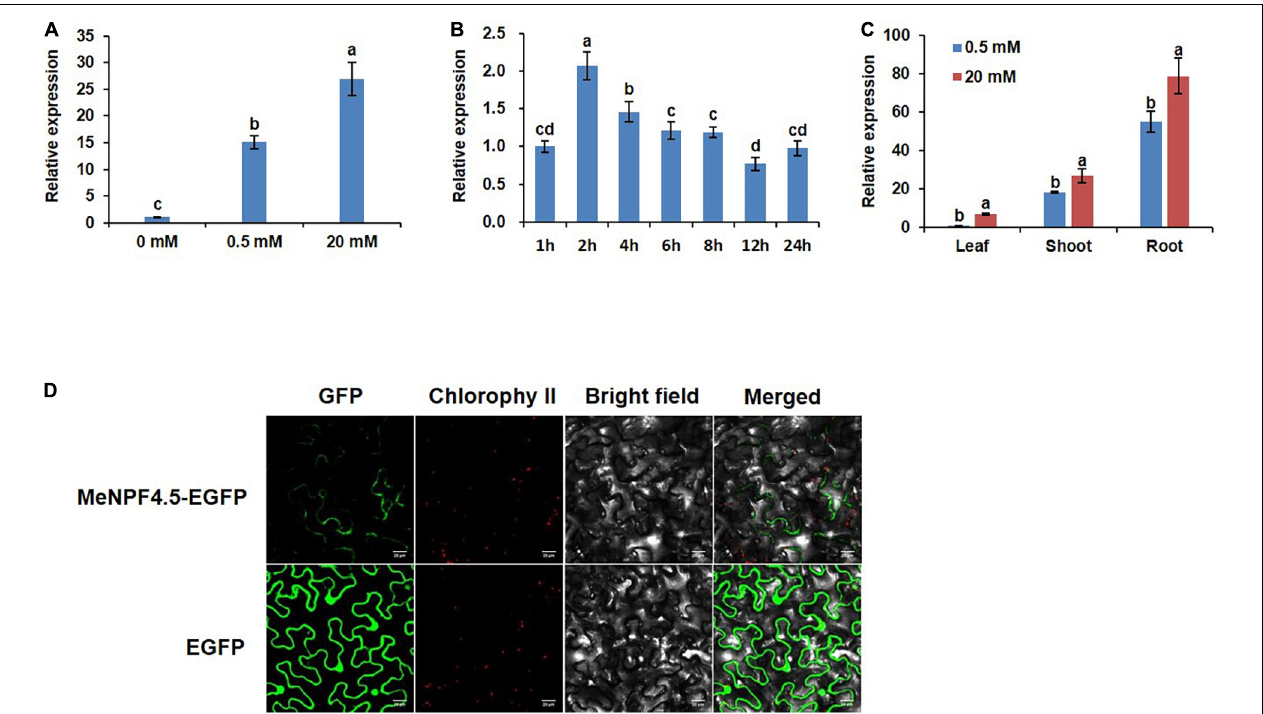
FIGURE 2 | Tissue-specific expression pattern and subcellular localization of the MeNPF4.5. (A) Relative expression of MeNPF4.5 in the roots of plants grown under different N conditions for 25 days. (B) Expression levels of MeNPF4.5 in N-starved roots at different times after N induction. Wild-type (WT) seedlings were grown in 10 mM NO 3 − for 20 days and under N starvation for 2 days, then were transferred to 20 mM NO 3 − . (C) Expression of MeNPF4.5 in various tissues of cassava. Cassava seedlings were cultivated under different N conditions (0.5 and 20 mM NO 3 − ) in tissue culture for 25 days. Values are the means of three biological replicates ± SE. Lowercase letters above the bars (a–d) represent significant differences between treatments as determined by Student’s t -test ( P < 0.05). (D) Subcellular localization of the MeNPF4.5-EGFP fusion protein in tobacco leaf epidermal cells. From left to right, GFP fluorescence, chlorophyll fluorescence, bright field, and merged images are shown. Bars = 20 µ